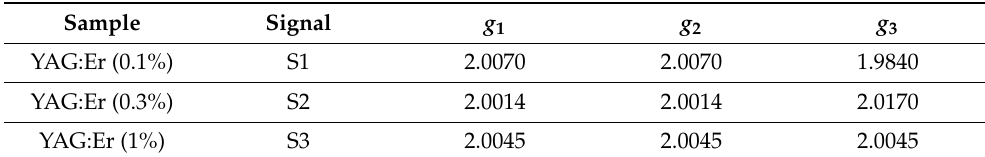
Table 1. Spin-Hamiltonian parameters from Equation (1). The error of g i ( i = 1–3) determination is ±